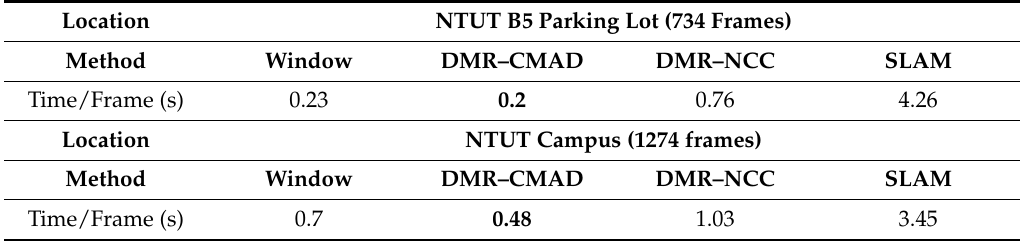
Table 2. Average localization times of the Window, DMR–CMAD, DMR–NCC, and SLAM